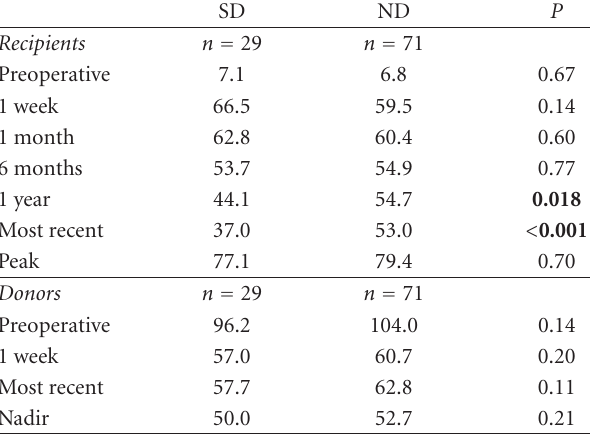
Table 2: Calculated glomerular filtration rates in mL/min per 1.73 m 2 of 200 patients at a single institution, including 100 kidney donors undergoing laparoscopic donor nephrectomy as well as their 100 recipients. Patients were stratified by donor tobacco history